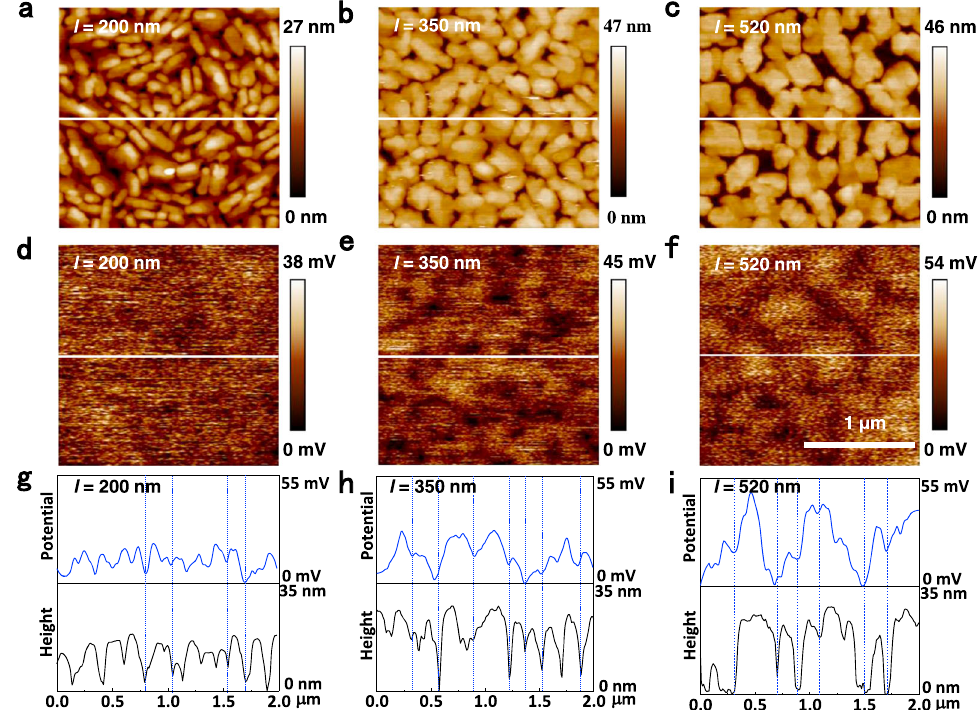
Fig. 4 The topography and surface potential characteristics of DNTT polycrystalline fi lms measured by Kelvin probe force microscopy (KPFM). a – c Topography images of DNTT polycrystalline fi lms with grain sizes of 200 nm, 350 nm and 520 nm, respectively. d – f Surface potential images of DNTT polycrystalline fi lms. g – i Line section pro fi le of topography and surface